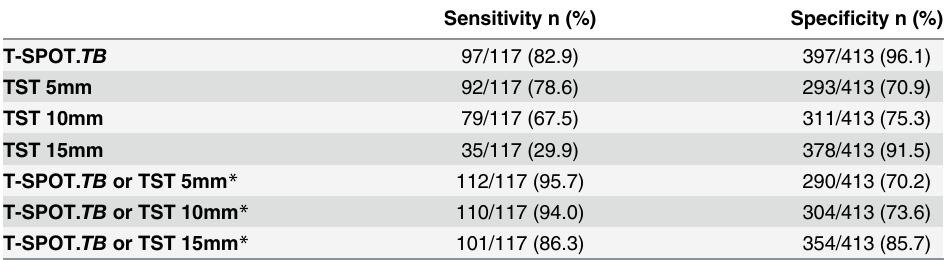
Table 5. Sensitivity of T-SPOT. TB and TST tests (singly and combined) in children with confirmed and clinically diagnosed tuberculosis using different cut-offs for